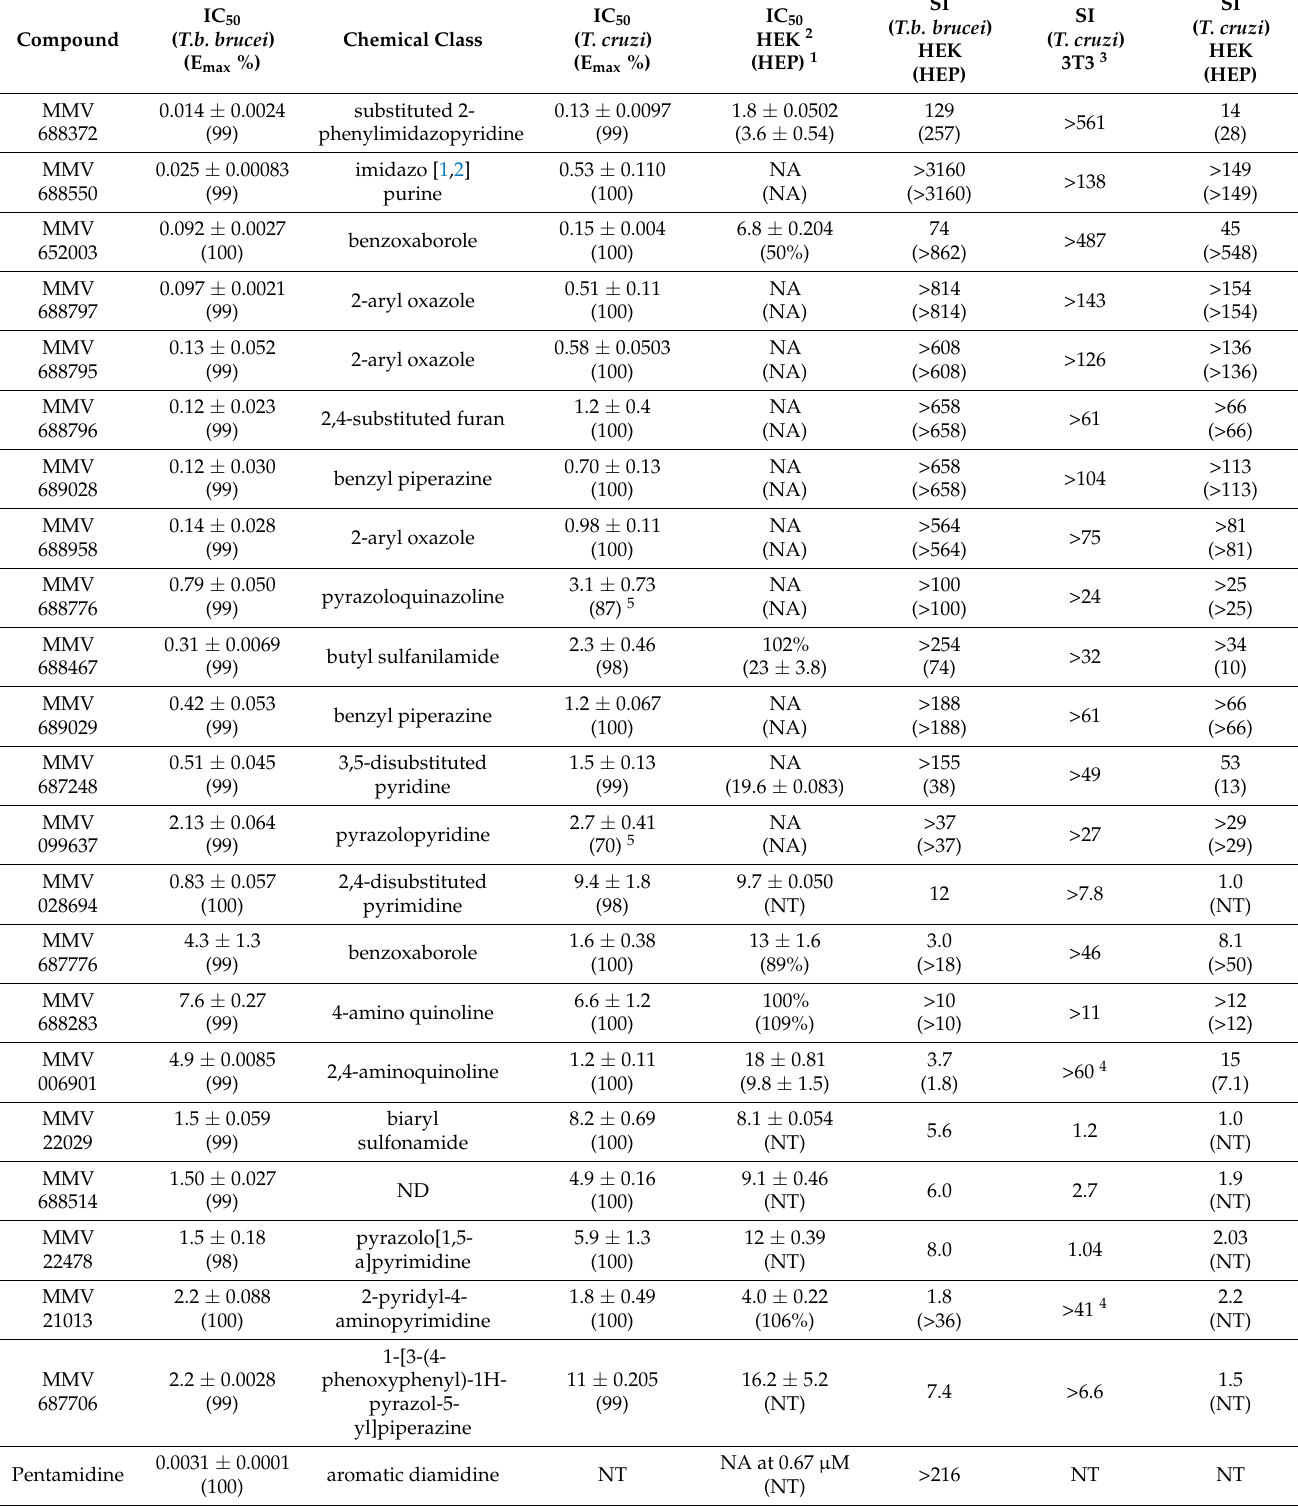
Table 1. Activity of compounds with activity against both T.b. brucei and T. cruzi parasites.